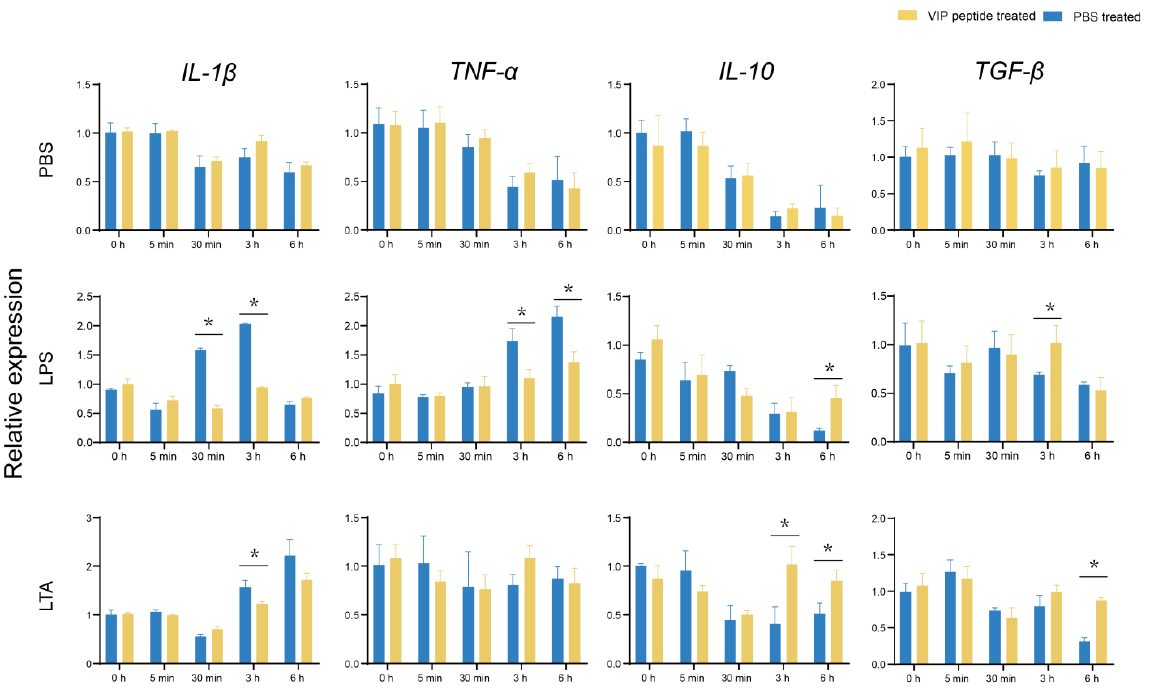
Figure 4. The relative expression of inflammatory-related factors ( IL-1β , TNF-α , IL-10 , and TGF-β ) after LPS and LTA challenged of tilapia MO/MΦ was analyzed using qRT-PCR. Every value is presented as the mean and standard deviation; n = 3. The asterisks reveal the significant difference ( p < 0.05).